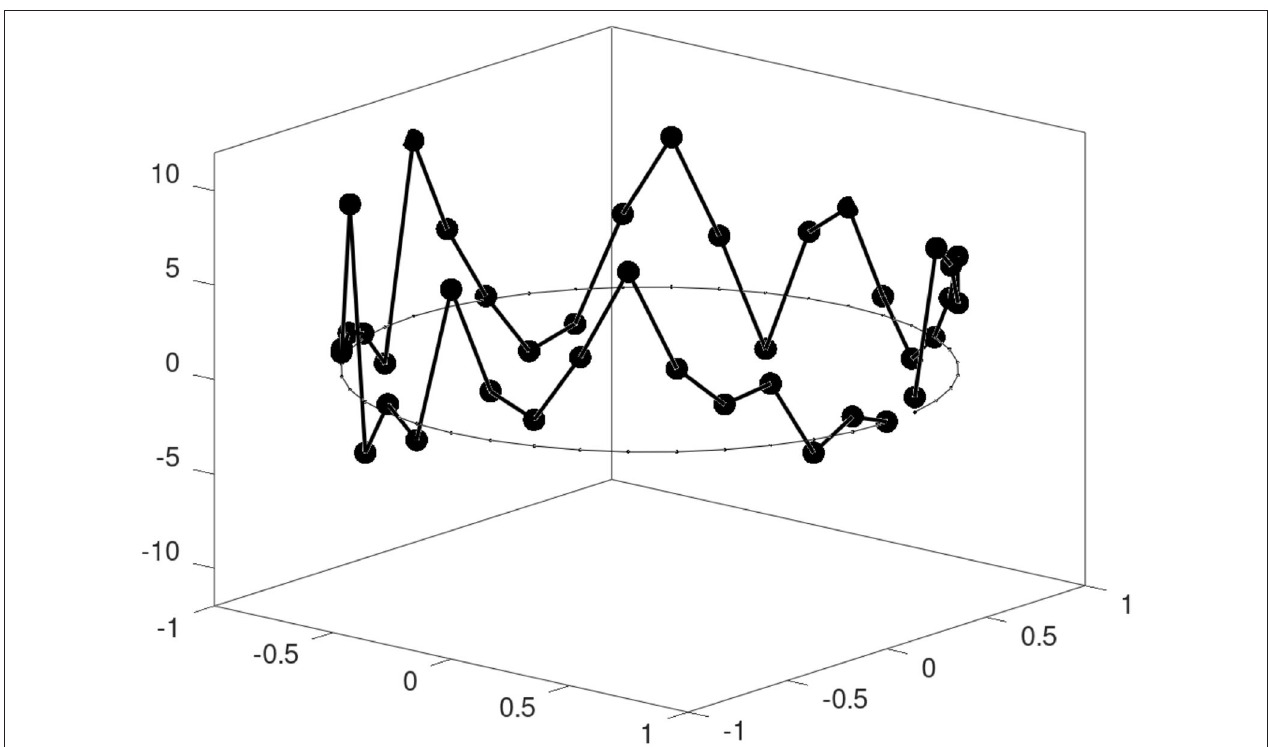
FIGURE 1 | Set-up for Lorenz 1996 model with n